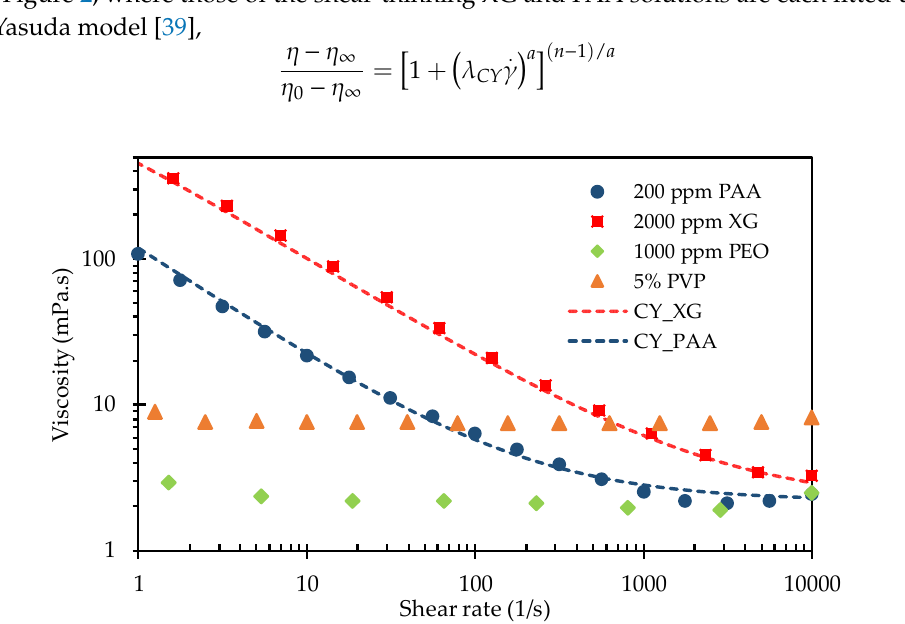
Figure 2. Experimentally measured viscosity data (symbols) of the prepared non-Newtonian fluids, where the dotted lines show the curve-fitting for the two shear-thinning xanthan gum (XG) and polyacrylamide (PAA) solutions using the Carreau–Yasuda model. Table 1. Rheological properties of the prepared fluids. Note the elasticity number, 𝐸𝑙 , was calculated at the flow rate of 10 mL/h.